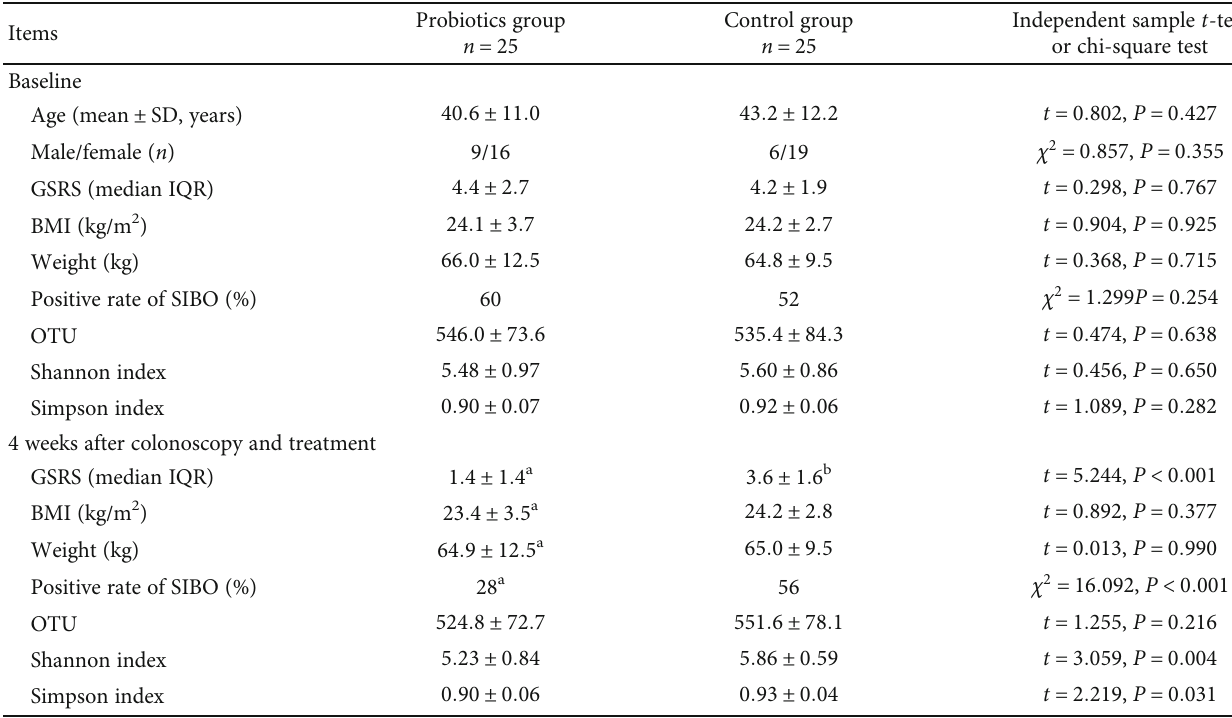
Figure 1: Flow chart of enrollment. Table 1: Participant data ( x ± SD , n ,